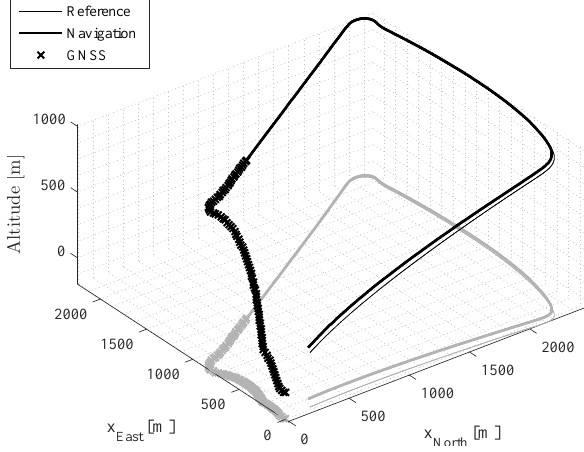
Figure 3: Reference trajectory and the solution from a sample rum with GNSS signals available during first 100 s only